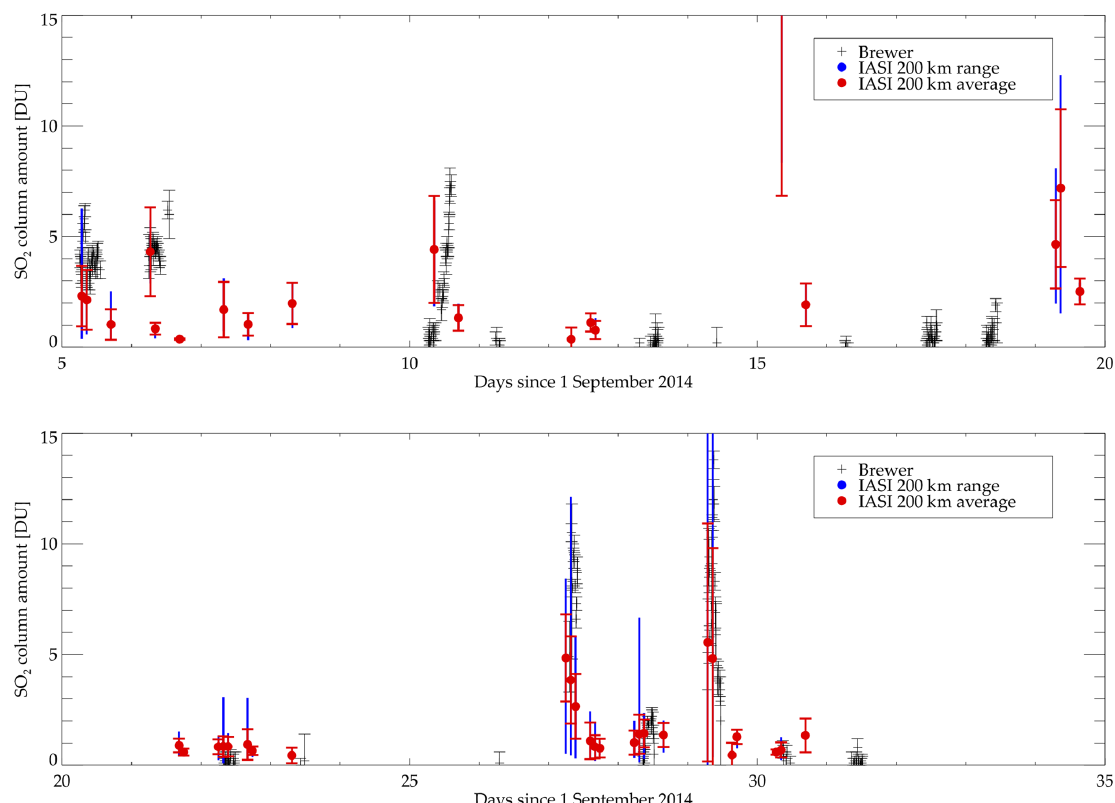
Figure 6. Time series of the SO 2 column amount (DU) measurements at Sodankylä as a function of day from the 1 September 2014. Black symbols are the Brewer measurements with error bars, red symbols are the mean and standard deviation of all the IASI measurements within 200km, and blue lines represent the maximum and minimum of the IASI